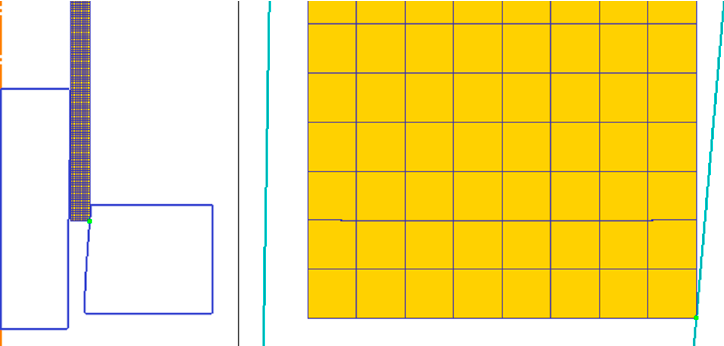
Figure 6. Mesh at initial step and detail of contact between tube and die.